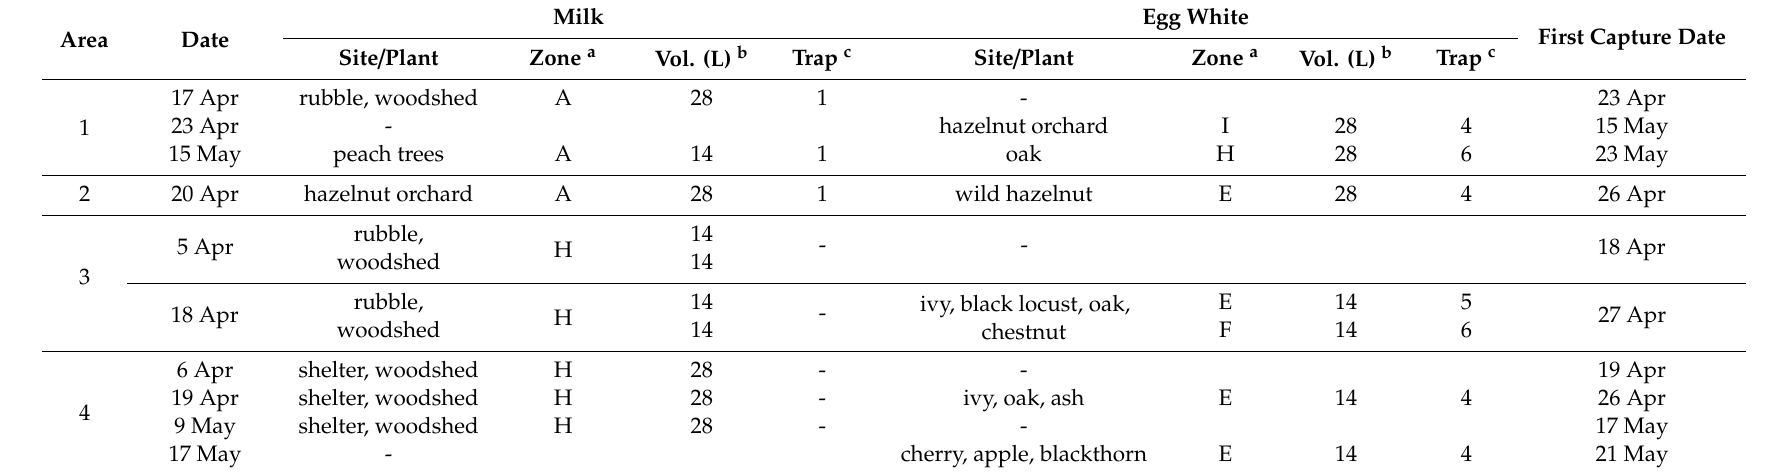
Table 2. Details of the immunomarking-capture technique employed in the four